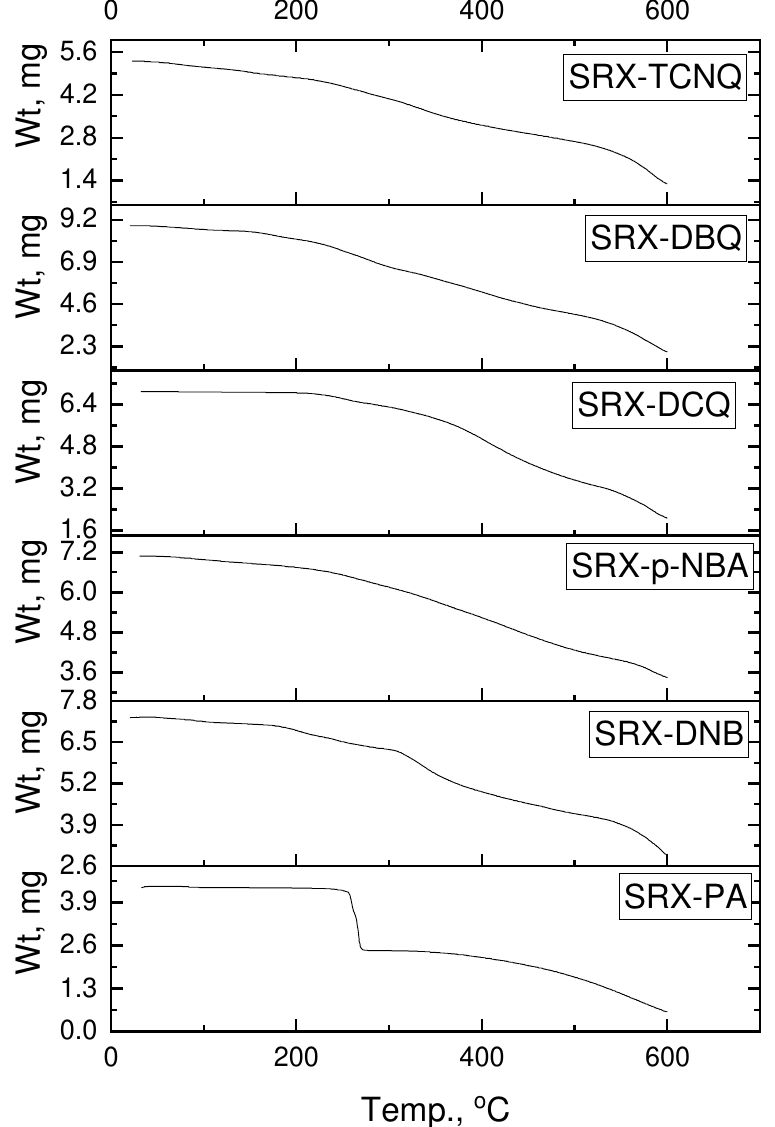
Figure 3. TGA curves of (1:1) charge-transfer complexes [(SRX)(π-acceptor)].